Question: Write a single sentence explaining what this figure depicts.
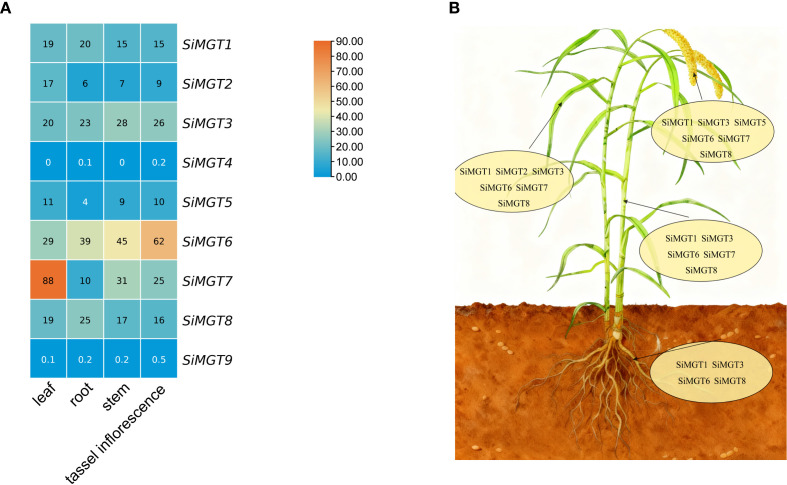
Answer: Tissue-specific expression patterns of SiMGT genes. (A) Heatmap of SiMGT gene expression in roots, stems, leaves, and panicles. Color intensity represents normalized expression levels (z-score of FPKM). (B) Expression levels of SiMGT genes in different tissues. Data are presented as mean ± SD of three biological replicates.